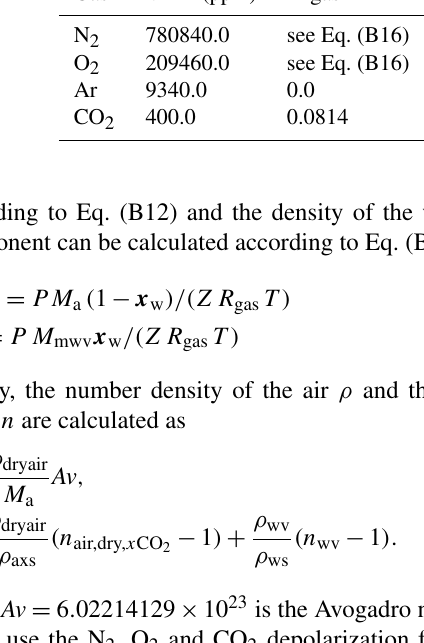
Table B1. Depolarization ratios and VMR for main air constituents